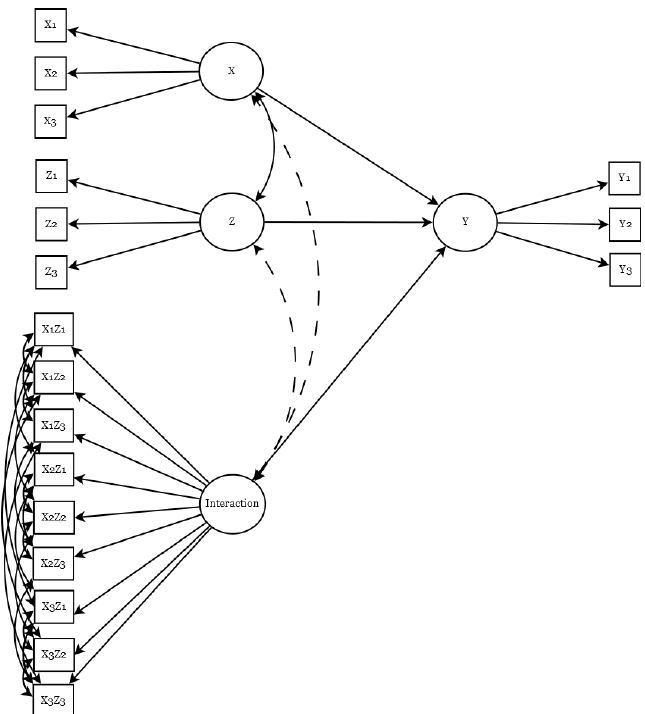
Figure 1. Path diagrams of unconstrained latent interaction models for both residual and mean centering. Dotted lines represent covariances estimated in mean centering models but fixed to 0 in residual centering